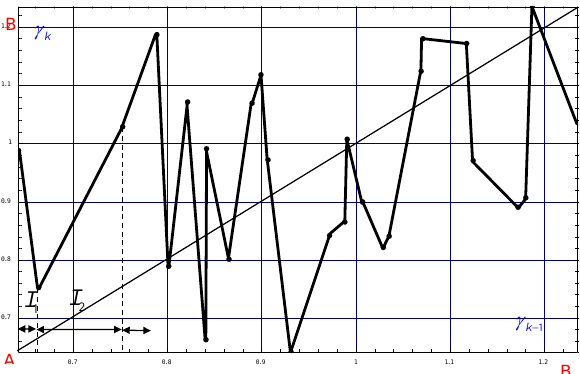
Fig. 9. Plot of the cycle-to-cycle evolution of the γ n parameter for n = − 4, ..., 23. A peculiar pattern appears for n =3 to 6, with a unique consistent linear trend during 4 cycles. This time inter- val matches a known period of attenuated activity called the Dalton Minimum.